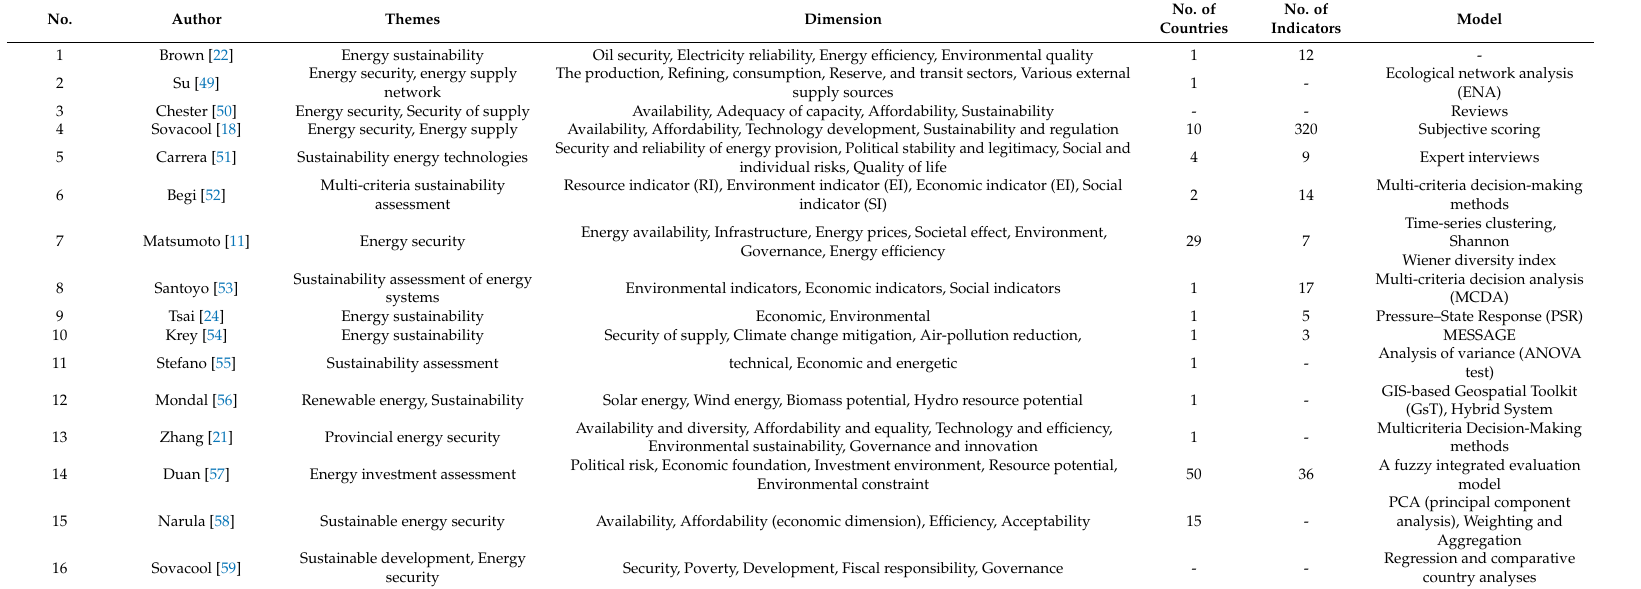
Table 1. Primary studies on energy sustainability dimensions: indicators and